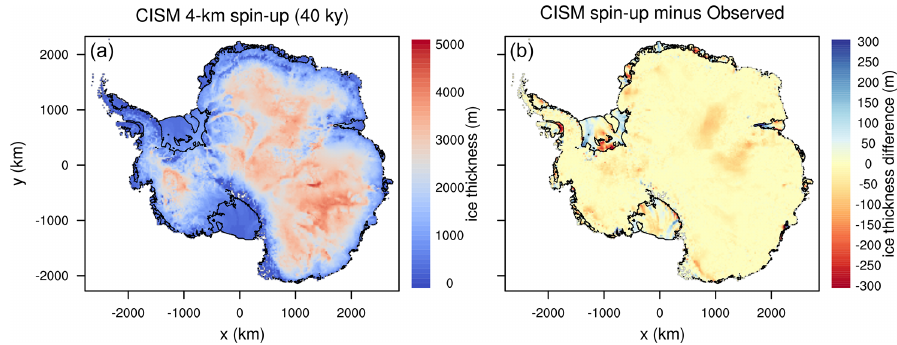
Figure 3. Modeled ice thickness (m) (a) and difference between modeled and observed ice thickness (b) . Observations are from the BedMa- chine Antarctica dataset (Morlighem et al., 2020).